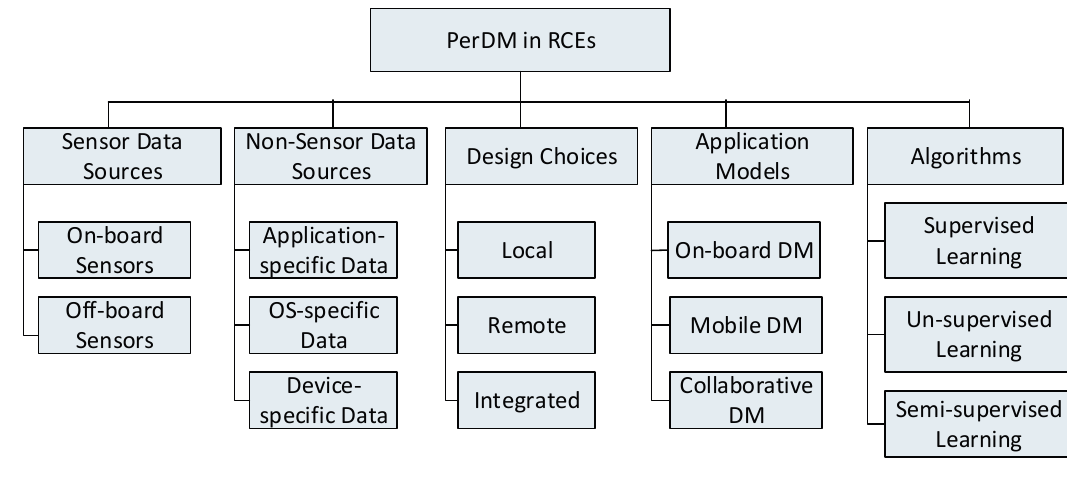
Figure 2. Taxonomy of PerDM in